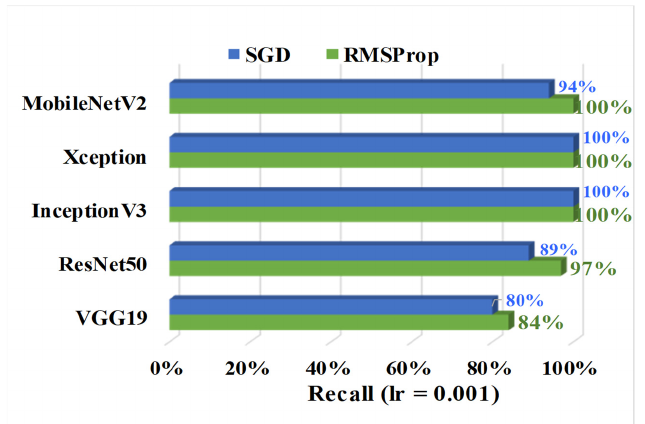
Figure 5. Defects classification: comparison of the evaluation metrics based on SGD and RMSprop optimization function for learning rate 0.001.